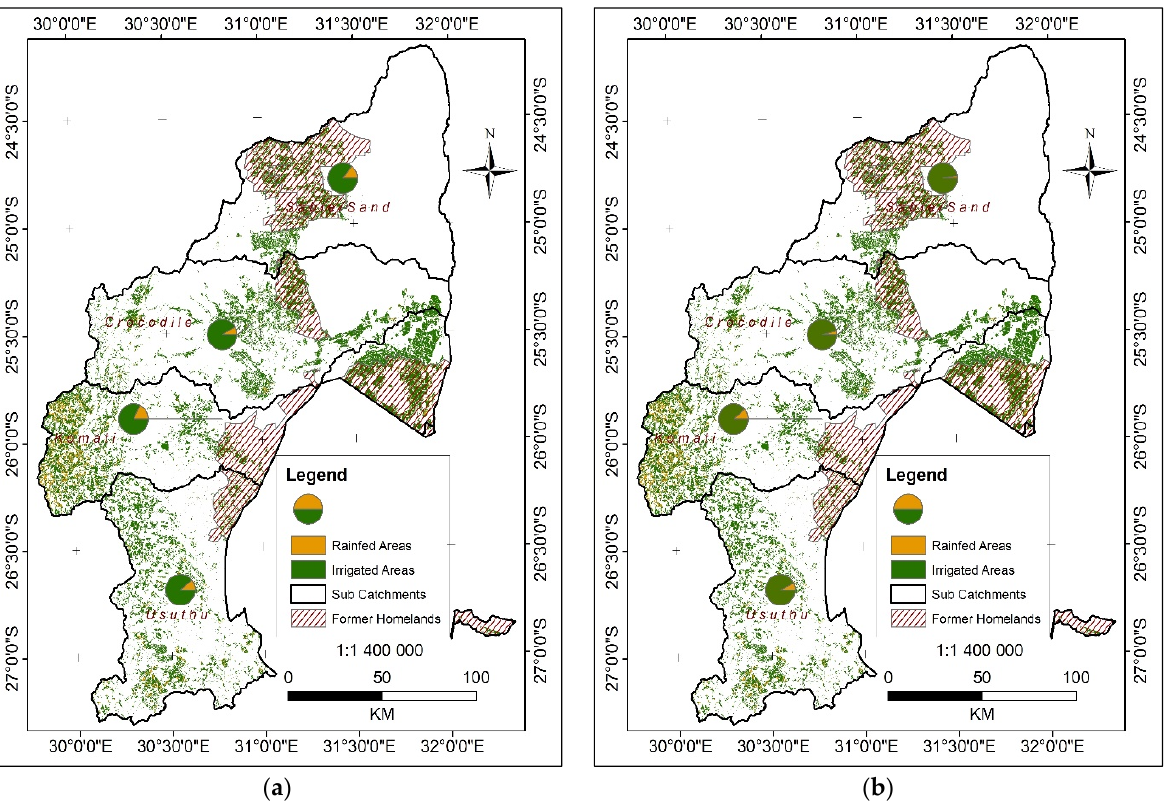
Figure 5. Distribution of cropped areas (irrigated and rainfed) in the IUWMA and the proportion between irrigated and rainfed areas per sub-catchment comparing 2019 (map ( a )) and 2020 (map ( b )).